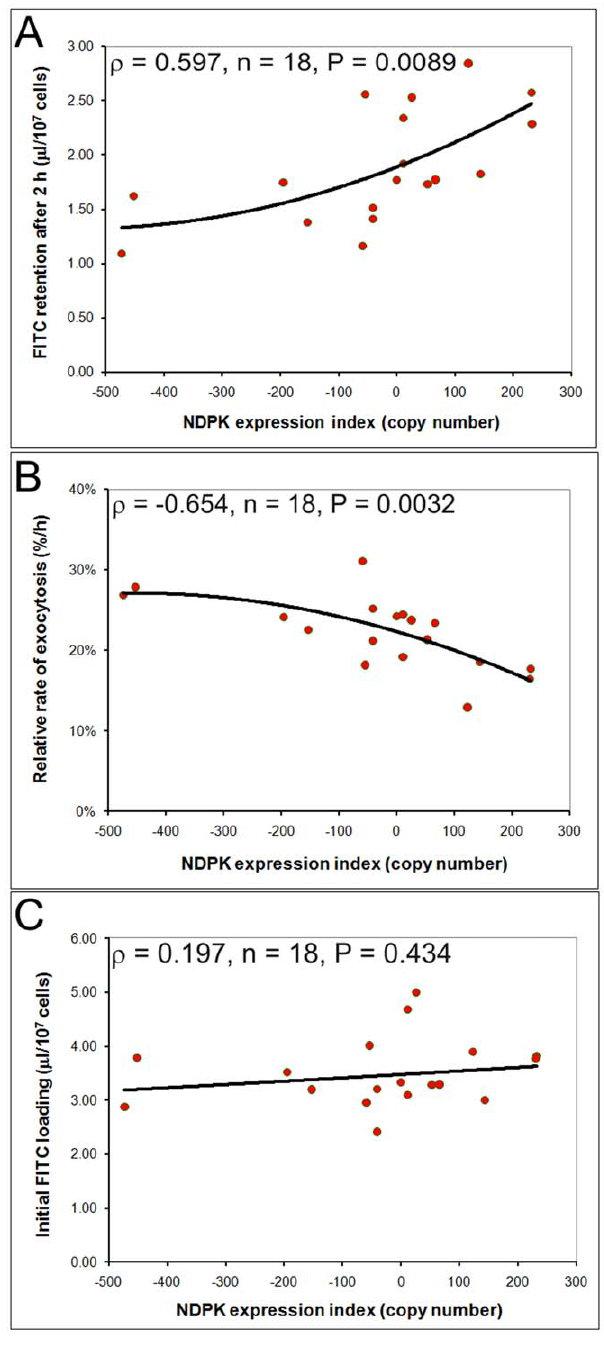
Figure 10. NDPK inhibits exocytosis. Duplicate measurements of the rate of exocytosis of FITC-Dextran were made in three independent experiments and the mean for each transformant plotted against the NDPK expression index (defined as in Fig. 5). A. Two hours after washing, the amount of FITC retained in the cells increased with the level of NDPK expression. The amount of FITC retained in the cells is expressed in terms of the equivalent volume of FITC-containing medium at the time of pinocytic uptake. B. The rate of exocytosis decreased as the level of NDPK expression increased. C. The steady state loading of FITC-dextran-containing medium was unaffected by NDPK expression levels. The correlation in both A and B was significant at P , 0.01, while the correlation in C was not significant at P . 0.1 (Pearson product-moment correlation coefficient r ). Lines of best fit in A and B were plotted using a 2 nd order polynomial function